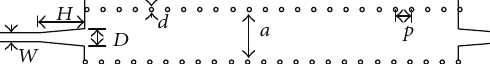
Figure 1: SIW with the microstrip transition.